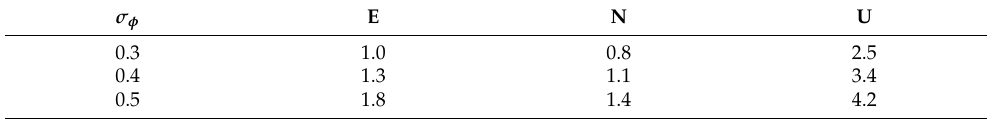
Table 3. The RMS of the PEs using different STDs of raw observations after convergence (unit: cm). σ φ E N